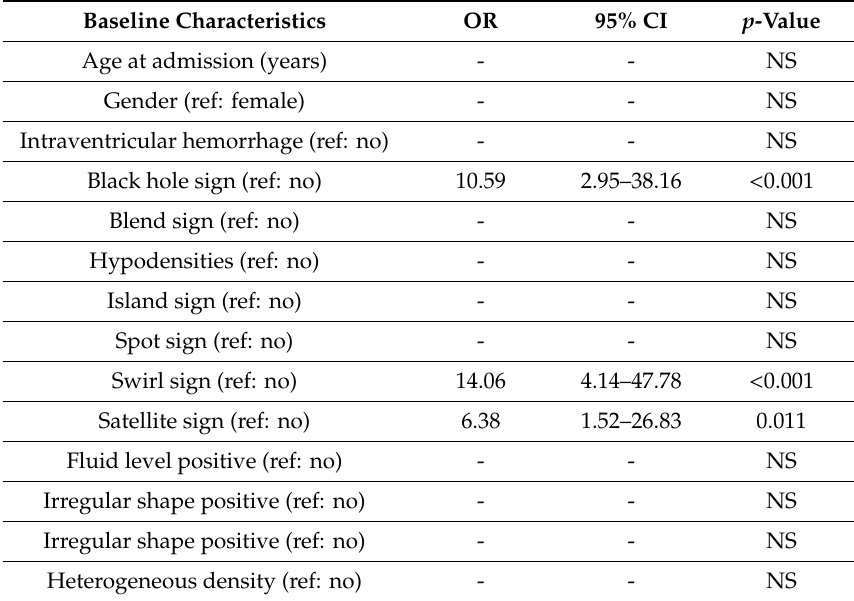
Table 4. Multivariable analysis of predictors for poor outcome: the final